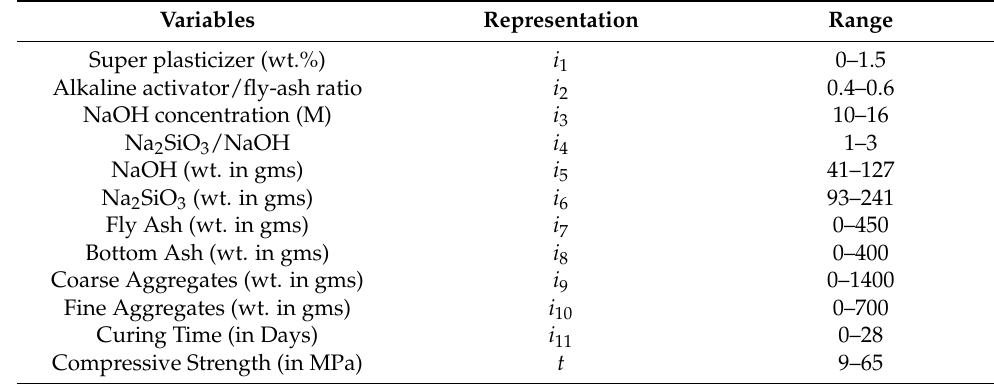
Table 1. Input and output parameters used for prediction of geopolymer concrete (GPC) compres- sive strength.